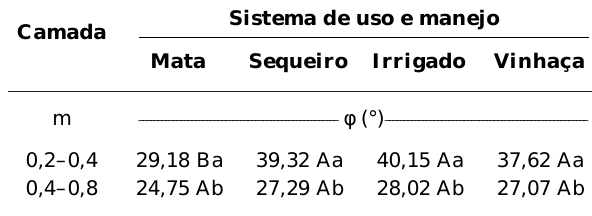
Quadro 3. Valores de ângulo de atrito interno do solo de ( φφφφφ ) acordo com os sistemas de manejo e profundidades no teor de água de 0,11 kg kg -1